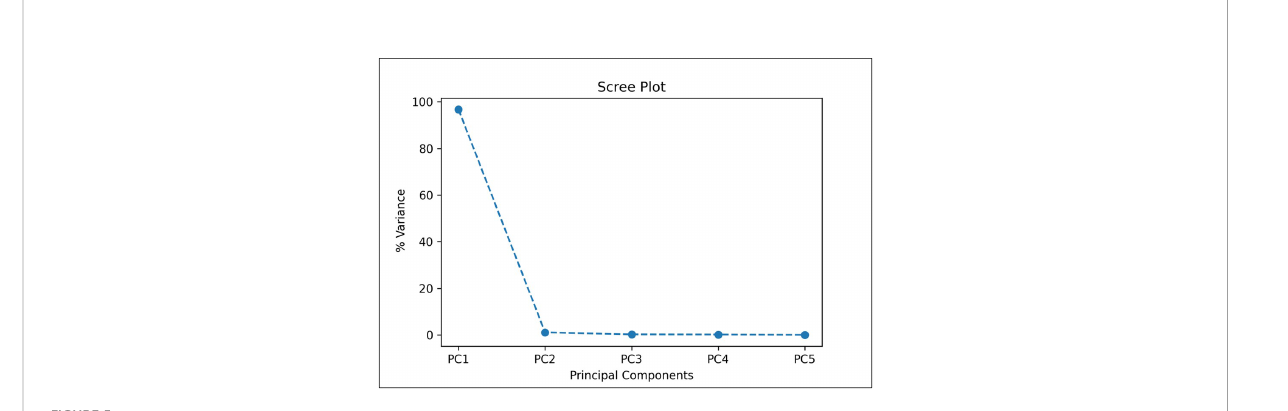
FIGURE 5 A scree plot of PCA analysis showing the percentage of variances accounted by each of the principal